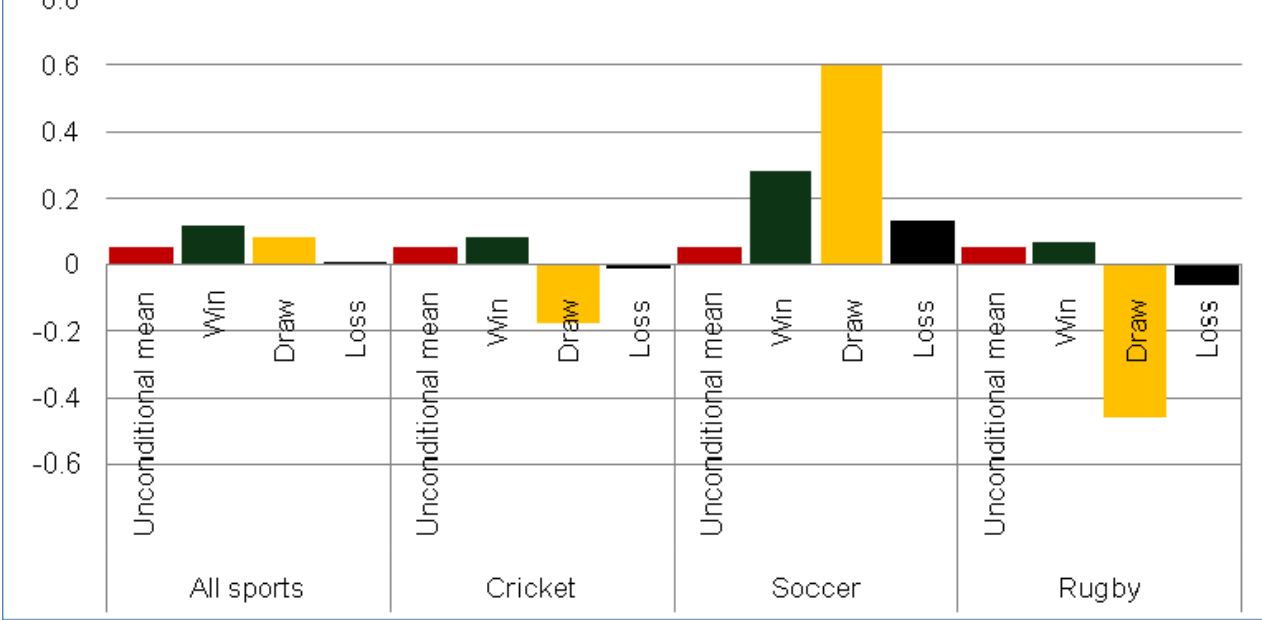
Figure 3: Comparison of mean daily returns